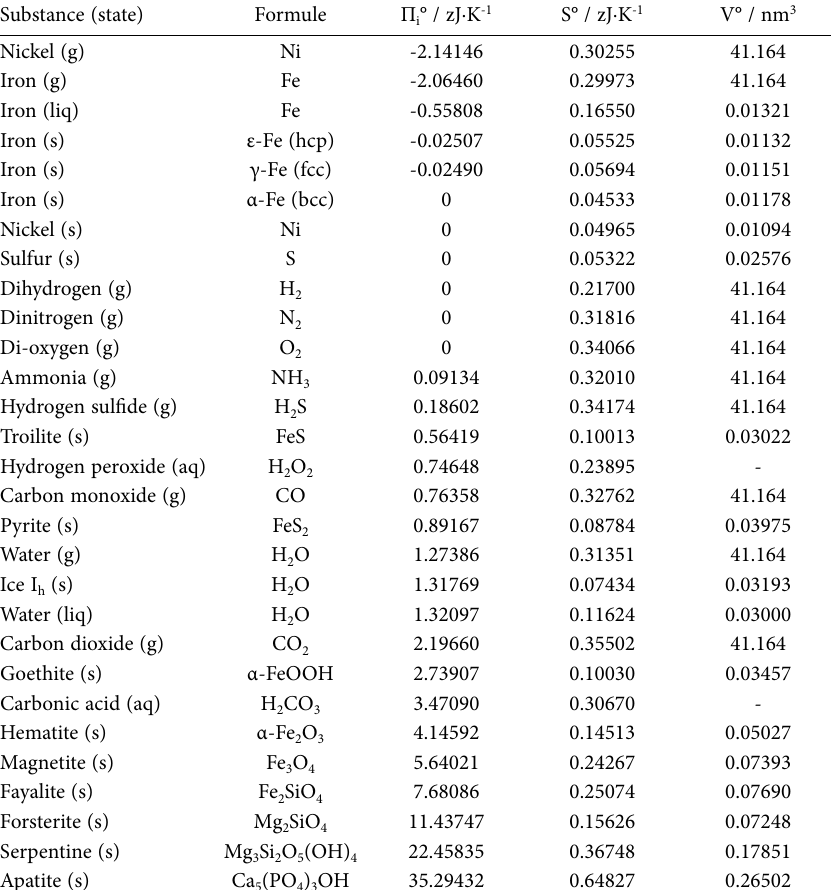
Table 1. Irreversible standard potentials Π i ° (T = 298.15 K, p = 100 kPa), standard absolute entropies S° and standard molecular volume V° for some selected compounds involved in the prebiotic metabolic cycle shown in figure 2. Values being given per molecule or motif, the unit of energy corresponds to the zepto-joule (zJ), with 1 zJ = 10 -21 joules and 1 kJ·mol -1 = 1,66 zJ. See annex for the derivation of this table from literature data. (s) = solid, (liq) = liquid, (g) = gas and (aq) = aqueous